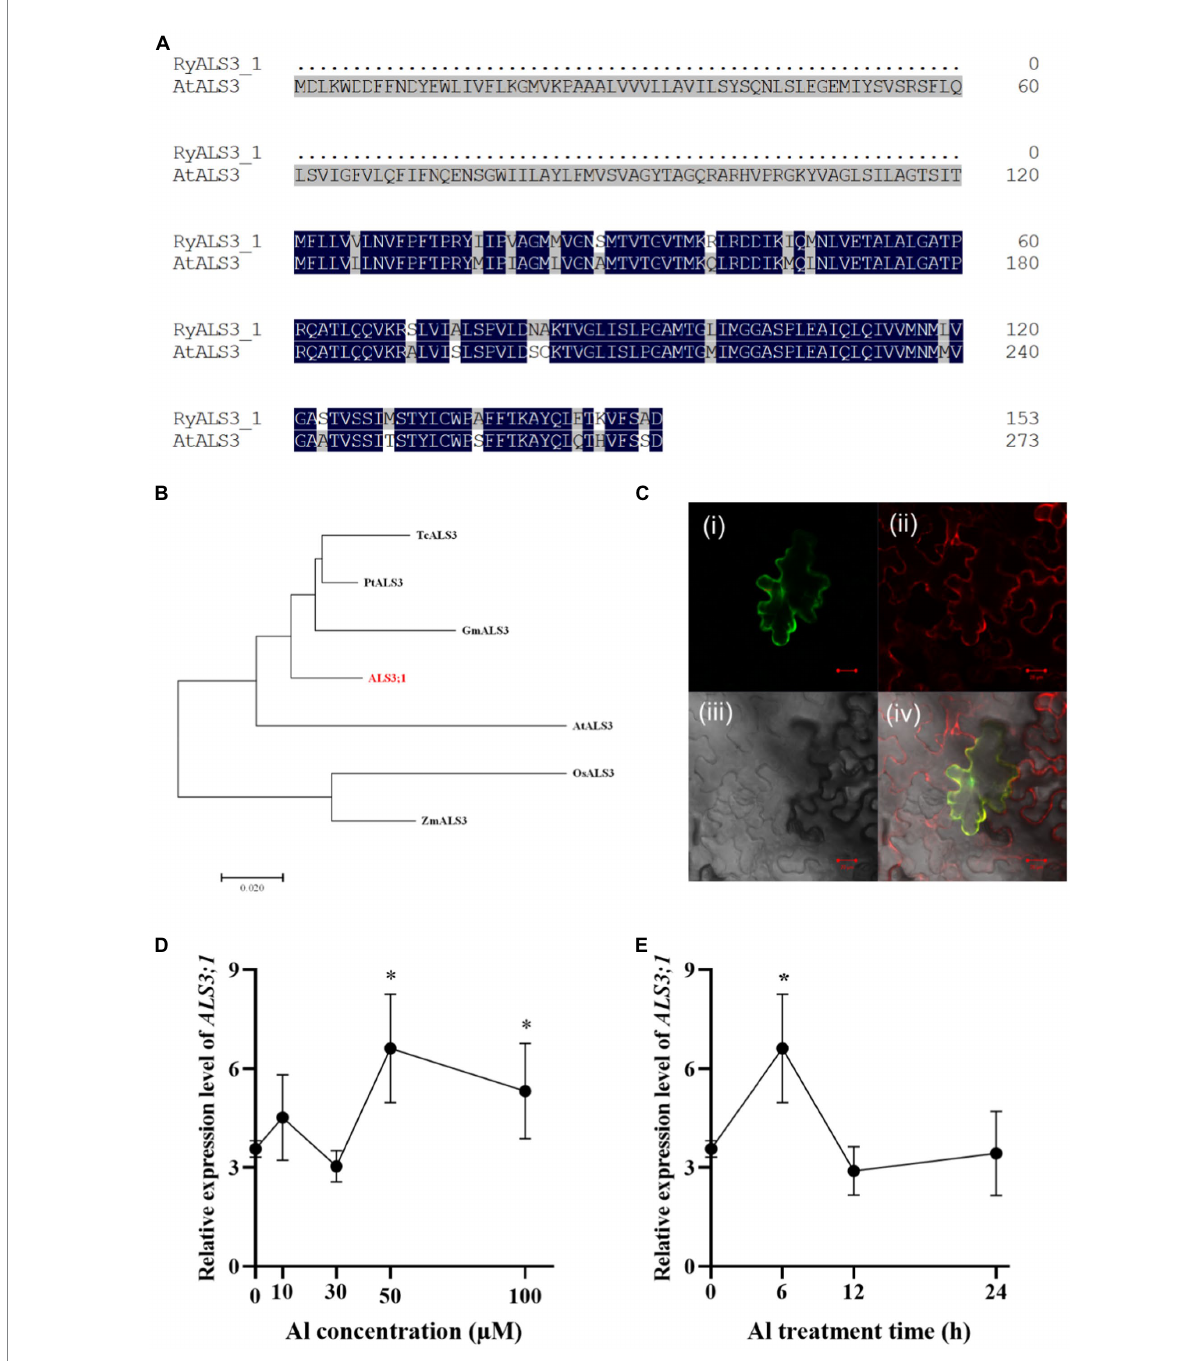
FIGURE 5 Amino acids alignment, phylogenic analysis, subcellular location, and expression of RyALS3;1 in R. yunnanense Franch. (A) Amino acid sequence alignment of R. yunnanense Franch ALS3;1 protein with Arabidopsis ALS3 (At2g37330). (B) Phylogenetic analysis of R. yunnanense Franch ALS3;1 and its close homologs. (C) RyALS3;1 is localized to the tonoplast. (i) RyALS3;1-GFP (green); (ii) tonoplast marker, vac-rk CD3-975 (red); (iii) bright field; (iv) a merged view of i–iii. Scale bar = 10 μ m. (D – E) Expression pattern of R. yunnanense Franch ALS3;1. Two-month-old seedlings were subjected to 1/5 nutrient Hoagland solution with 0, 10, 30, 50, or 100 μ M Al for 6 h (D) or with 50 μ M Al for different treatment time (E) . ACTIN was used as an internal control to normalize expression. Data are means ± SD ( n = 3 for biological repeats). Asterisks (*) represent a significant difference in comparison with 0 μ M Al